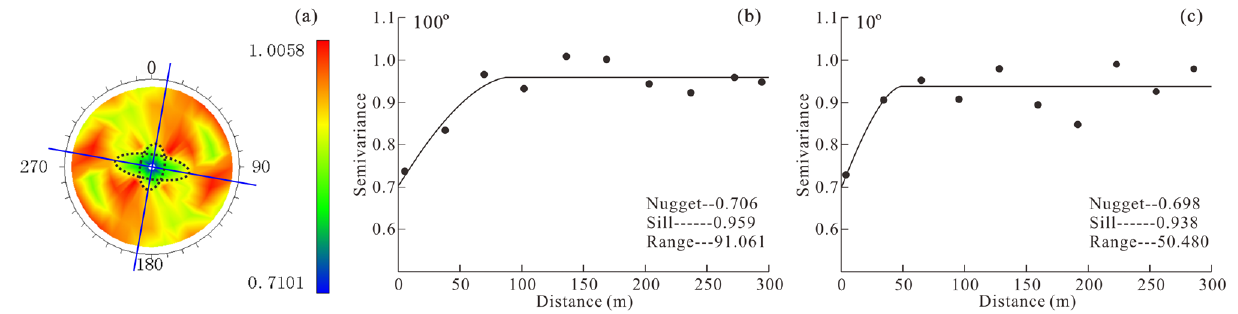
Figure 9. Semivariogram map of lg(Zn/Pb) values. ( a ) Omnidirectional semivariogram distribution map; ( b ) 100° direction semivariogram; ( c ) 10° direction semivariogram. Table 5. Results of semivariogram